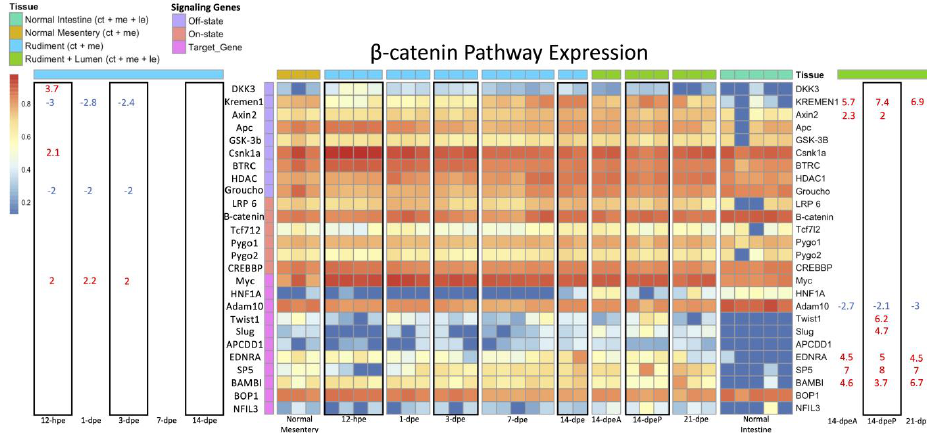
Figure 7. Heatmap of the signaling genes in the Wnt/β -catenin pathway. This figure is read the same as in Figure 5. The significance threshold remains the same. The only difference is that the rows are color coded to indicate the role of the gene in the Wnt/B-catenin pathway. Genes in the Off-state